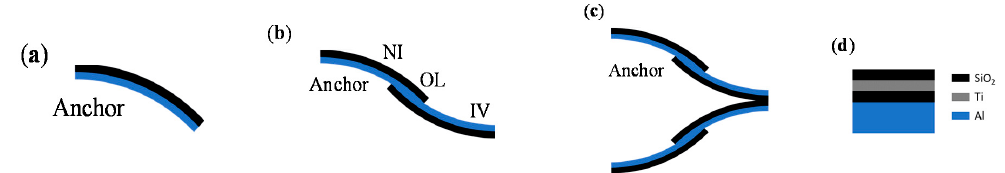
Figure 1. Electrothermal bimorph actuator design. ( a ) Simple bimorph beam; ( b ) inverted-series- connected (ISC) bimorph design; ( c ) Folded double ISC bimorph design; ( d ) A Ti heater embedded in the bimorph.